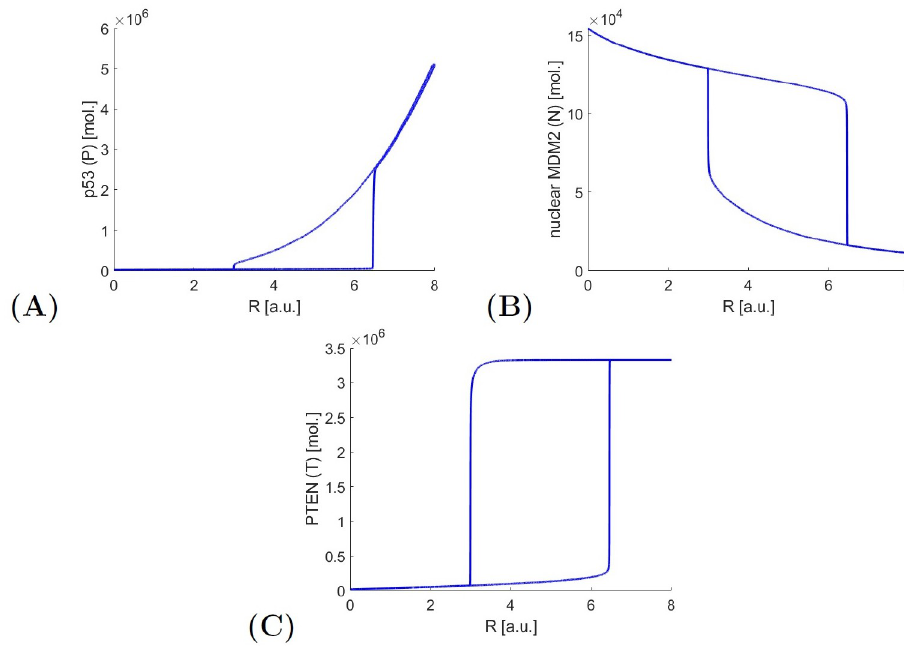
Fig 7. Bifurcation diagrams of protein levels for different stress levels—Nonlinear model. A: Bifurcation diagram for p53 ( P ); B: Bifurcation diagram for nuclear MDM2 ( N ); C: Bifurcation diagram for PTEN ( T ).